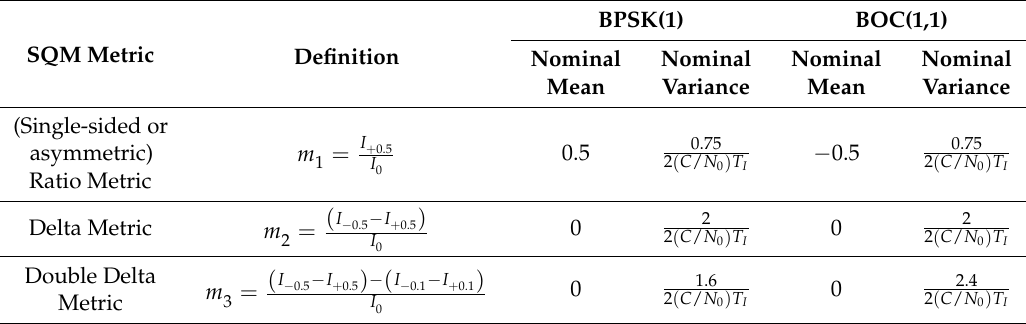
Table 1. Definition of SQM metrics and theoretical